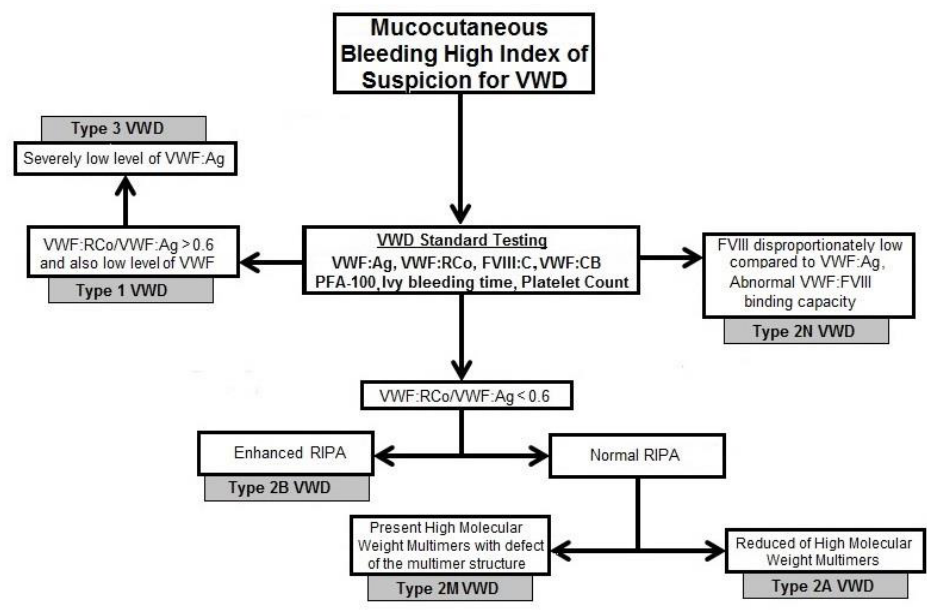
Figure 4. Algorithm for the diagnosis and classification of von Willebrand disease.